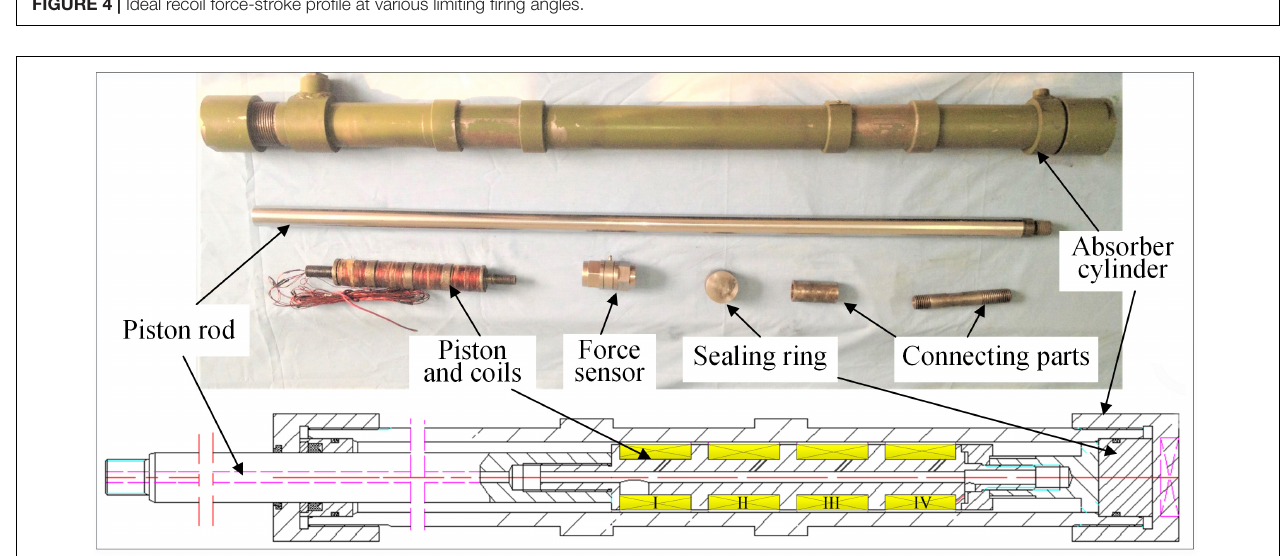
FIGURE 5 | Physical picture of designed MR